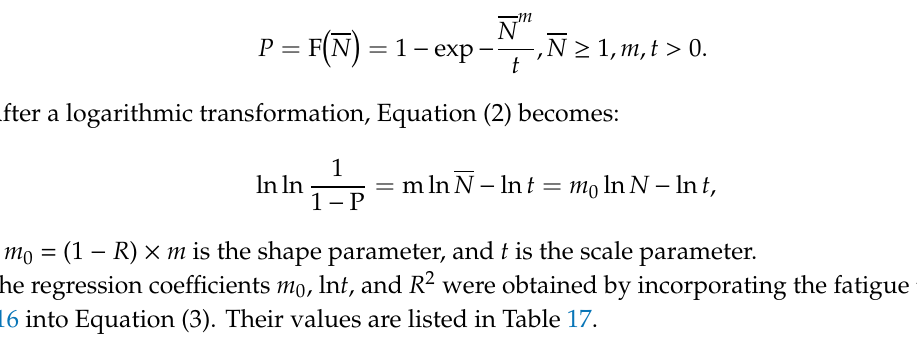
Table 17. Fatigue test results after fitting the data to the Weibull distribution.